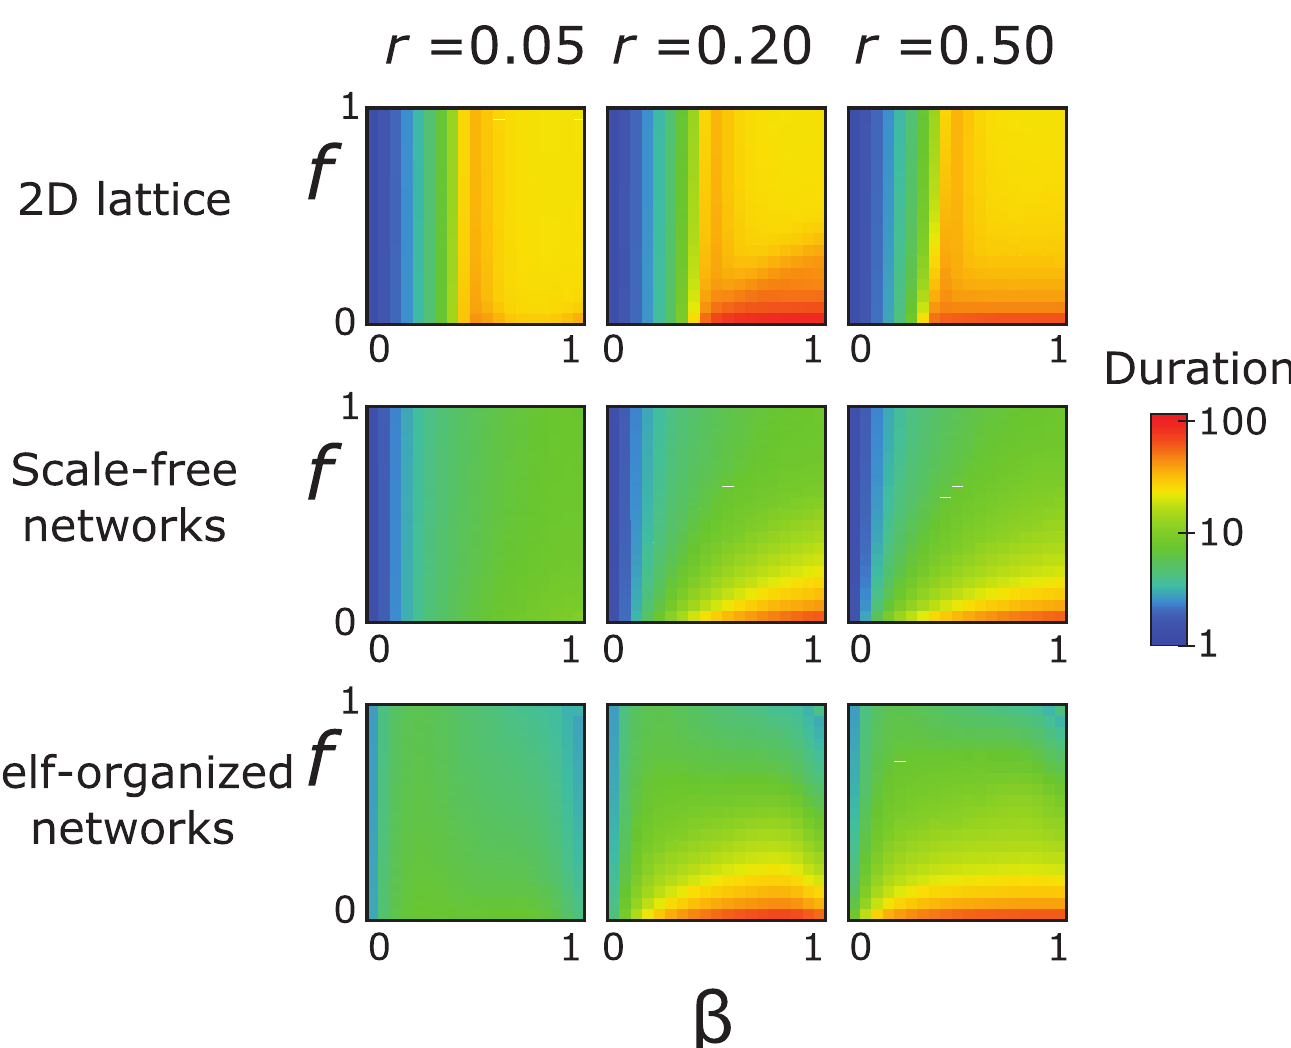
Fig 3. Duration of epidemic: time till stochastic die-out. From top to bottom: two-dimensional lattices, random scale-free networks ( λ = 2.5), and self- organized networks. The x-axis corresponds to the infection probability, β , and the y-axis to the death probability, f , of an infected node. The columns correspond to the protection loss rate, r , of a node (left to right): r = 0.05, r = 0.20, and r =